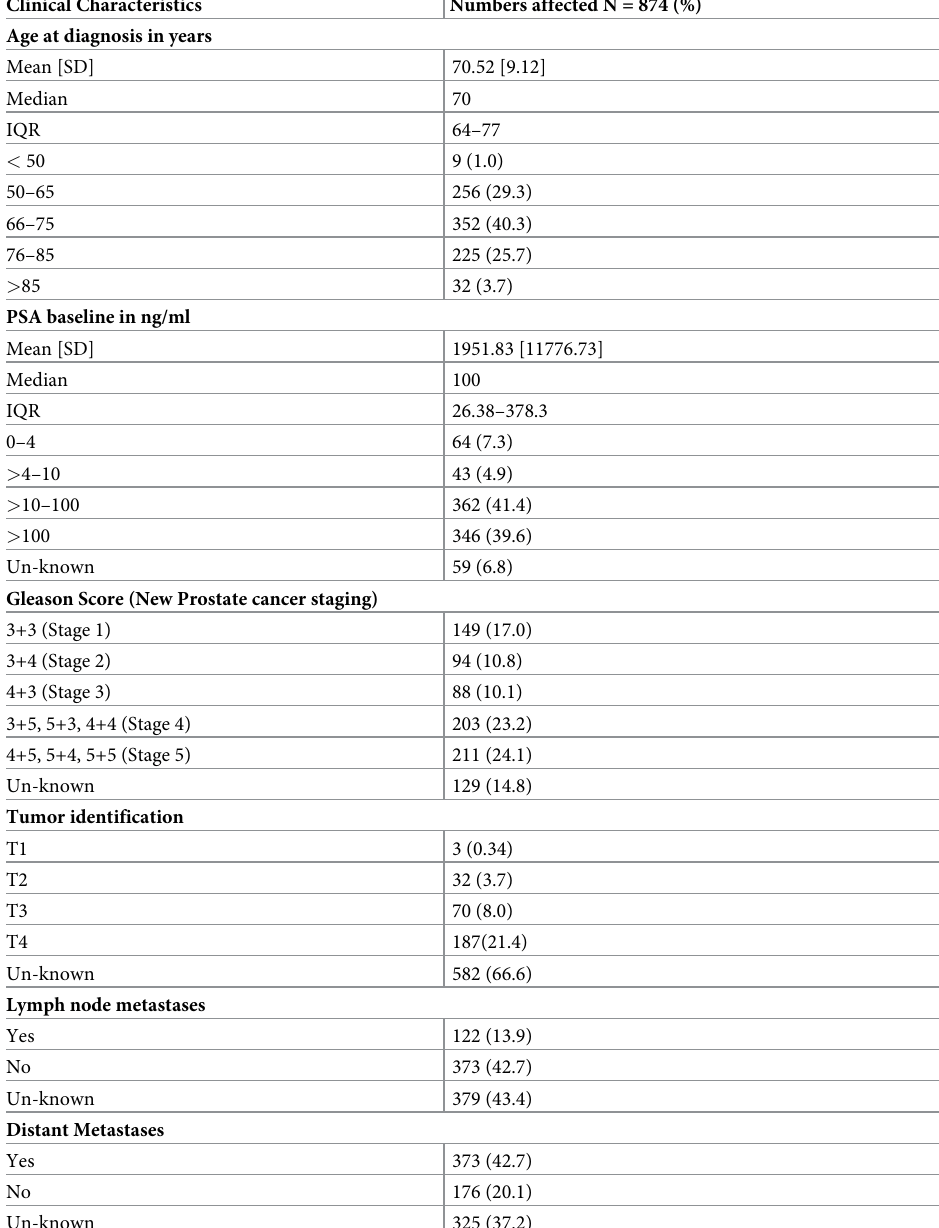
Table 1. Clinical characteristics of prostate cancer patients at the UCI from 2015 to 2019.